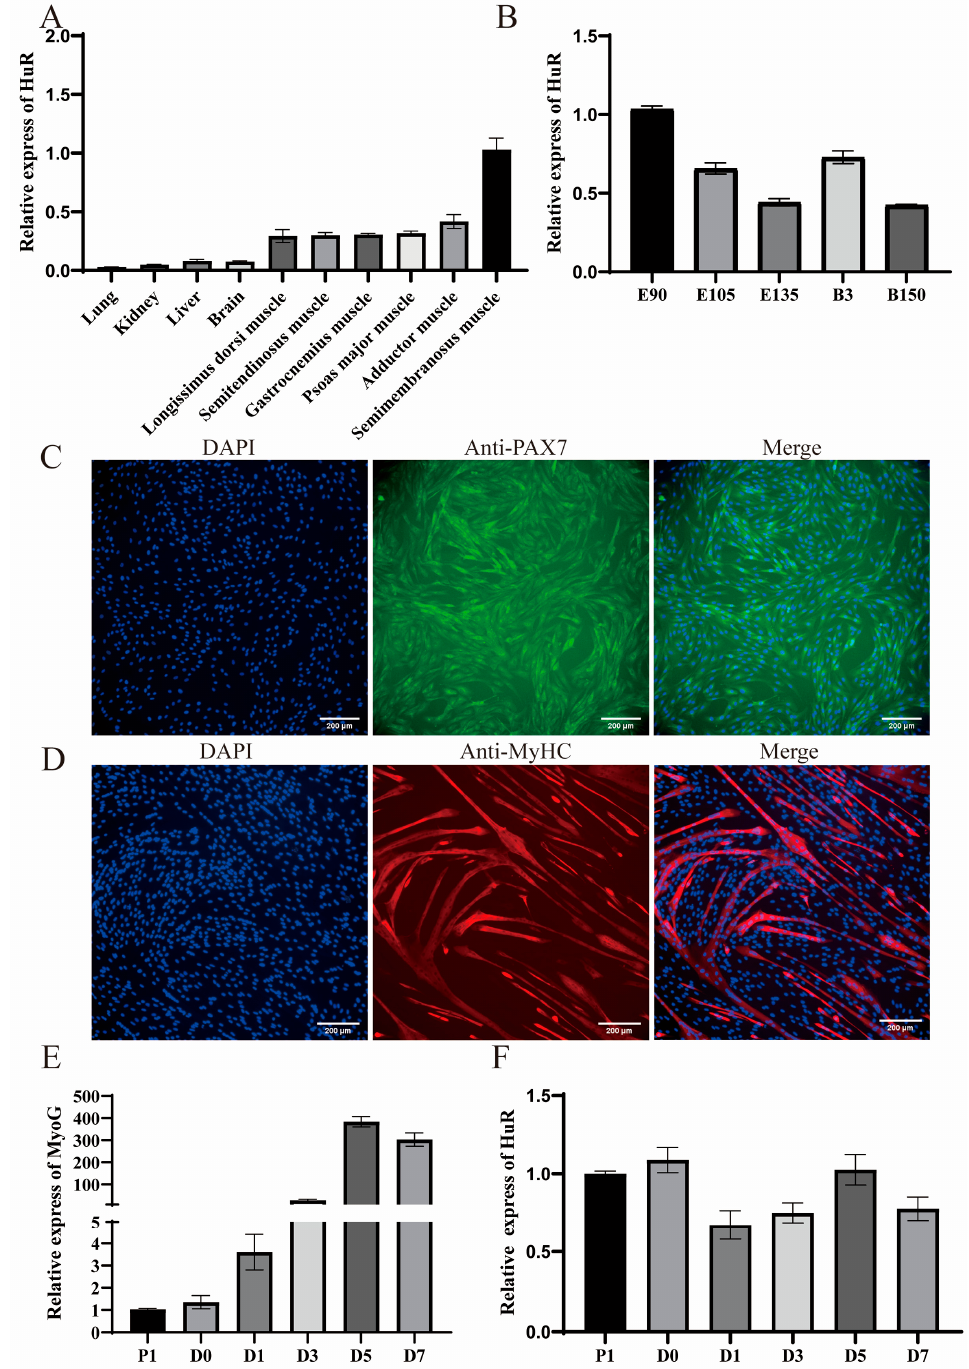
Figure 1. The expression profile of HuR. ( A ) qRT-PCR analysis of HuR expression in different tissues of goats on the third day after birth (B3). ( B ) The expression pattern of HuR in the developmental LD muscle. The embryonic period is defined as ( E ), and the postnatal period is defined as ( B ). ( C ) Rep- resentative immunofluorescence images of MuSCs stained using anti-Pax7 (green) and cultured in growth medium (GM). ( D ) MyHC immunofluorescence staining of MuSCs cultured in differentiation medium (DM) for 5 days. ( E ) The expression level of MyoG during MuSC differentiation (cultured in the growth medium (P1) and differentiation medium for 0, 1, 3, 5, and 7 days). ( F ) The expression pattern of HuR during differentiation of goat MuSCs (cultured in the growth medium (P1) and differentiation medium for 0, 1, 3, 5, and 7 days). Data are means ± standard error from at least three biological